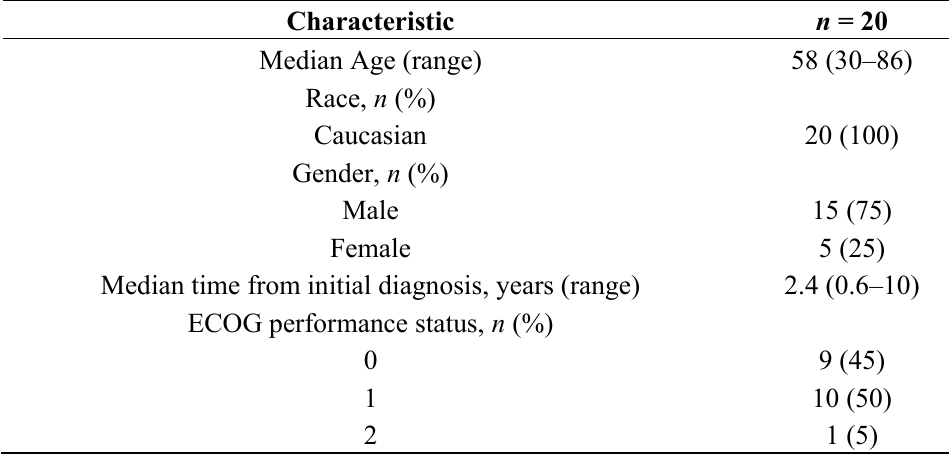
Table 1. Baseline Patient